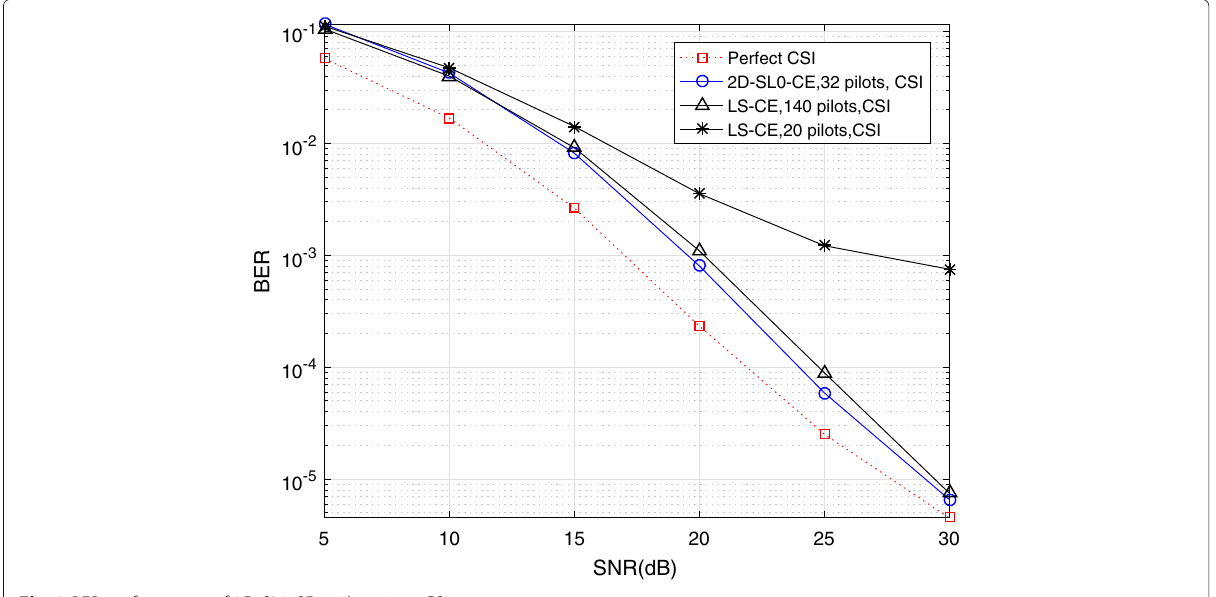
Fig. 2 BER performance of 2D-SL0-SD with various CSIs